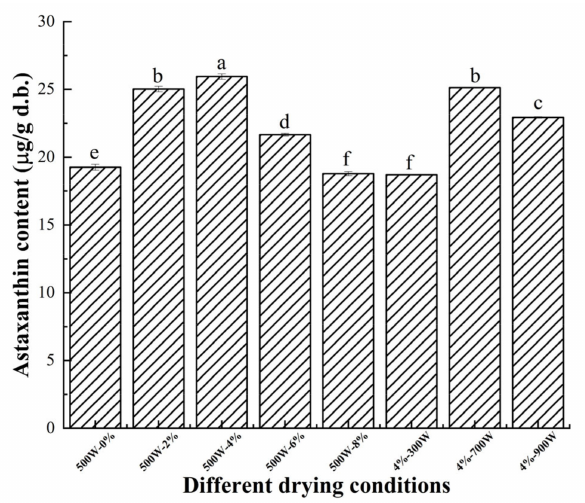
Figure 7. Changes in total astaxanthin content ( µ g/g) (dry weight) of shrimps after MW drying under different salt concentrations and MW powers. Different letter indicates statistically significant difference at p < 0.05 according to the Duncan